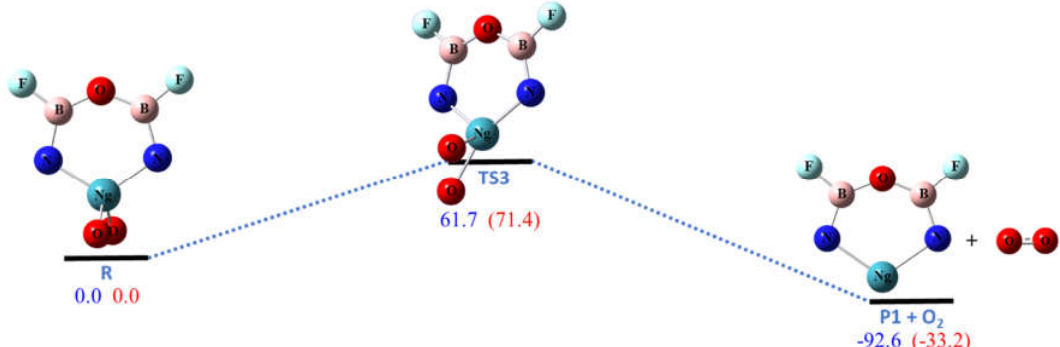
Pathway R3 is the one-step dissociation of O